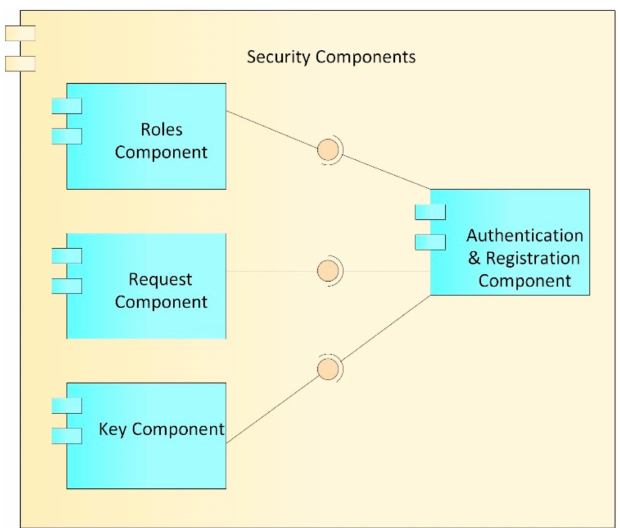
Figure 6. Security components.